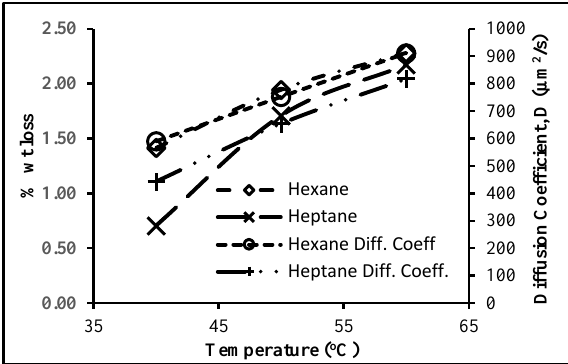
Figure 12. Percentage weight loss and diffusion coefficient at different temperatures during first hour of solvent extraction for F2 feedstock formulation.